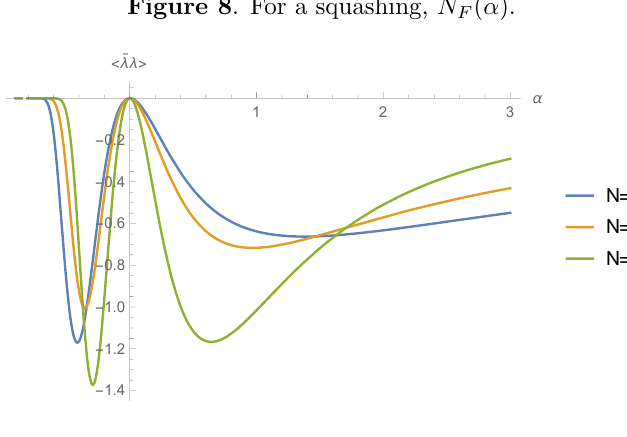
Figure 8 . For a squashing, N F ( (cid:11) ).